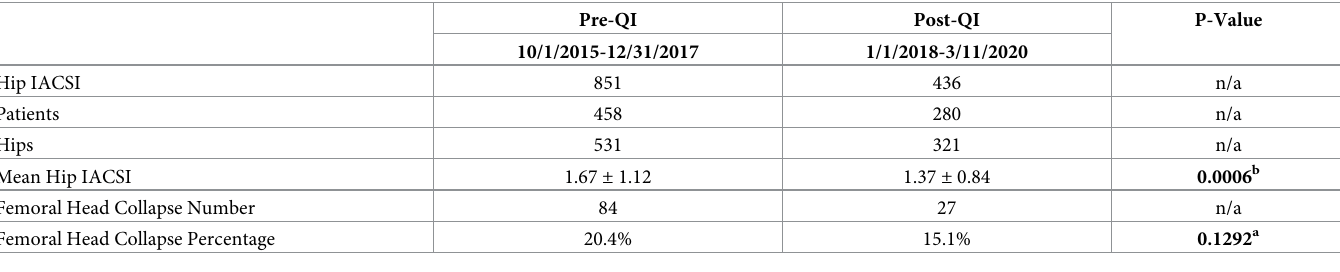
Table 3. Hip IACSI QI